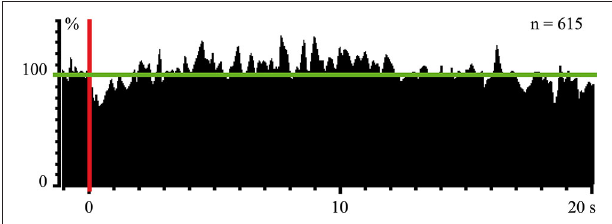
FIGURE 4 | Population response of 61 neurons (615 trials) in monkey’s cortical visual area V4 to magnetic stimulation of stomach during SWS. Vertical red line–moment of stimulation. Horizontal green line indicate mean background firing rate before stimulation taken as 100%. Technical details of the study in Pigarev et al.